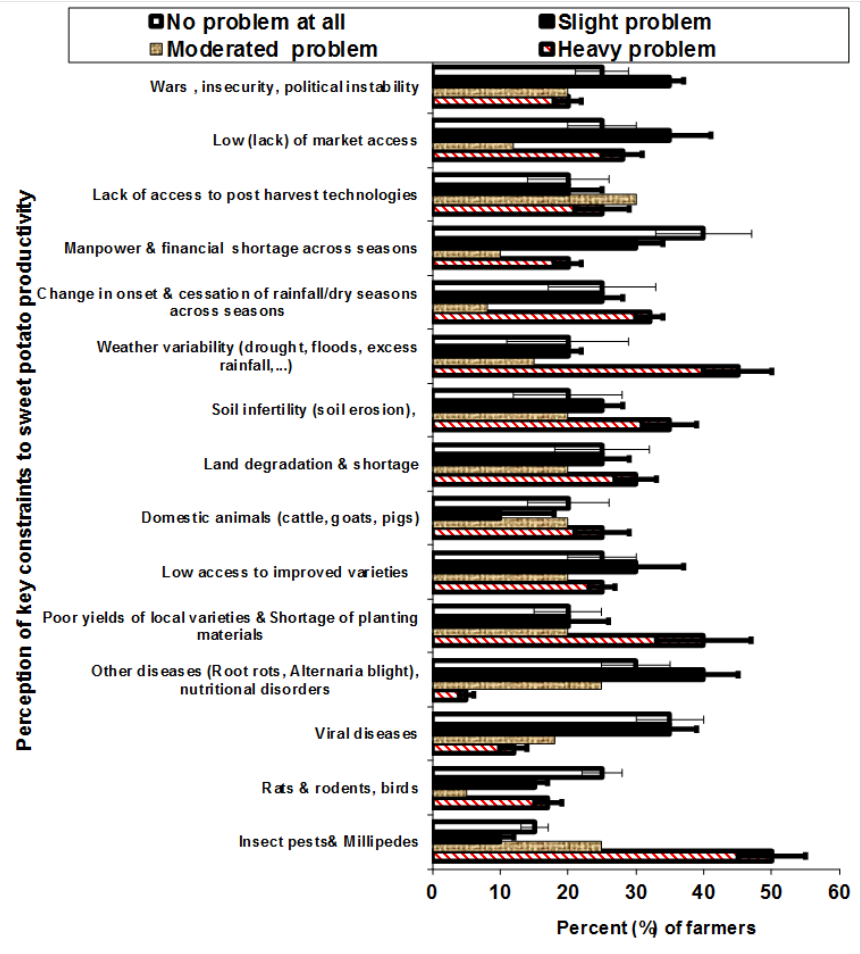
Figure 1a. Farmers ‘perception (belief) of the magnitude (scale level) of key constraints to sweet potato productivity in South-Kivu Province, eastern DRCongo